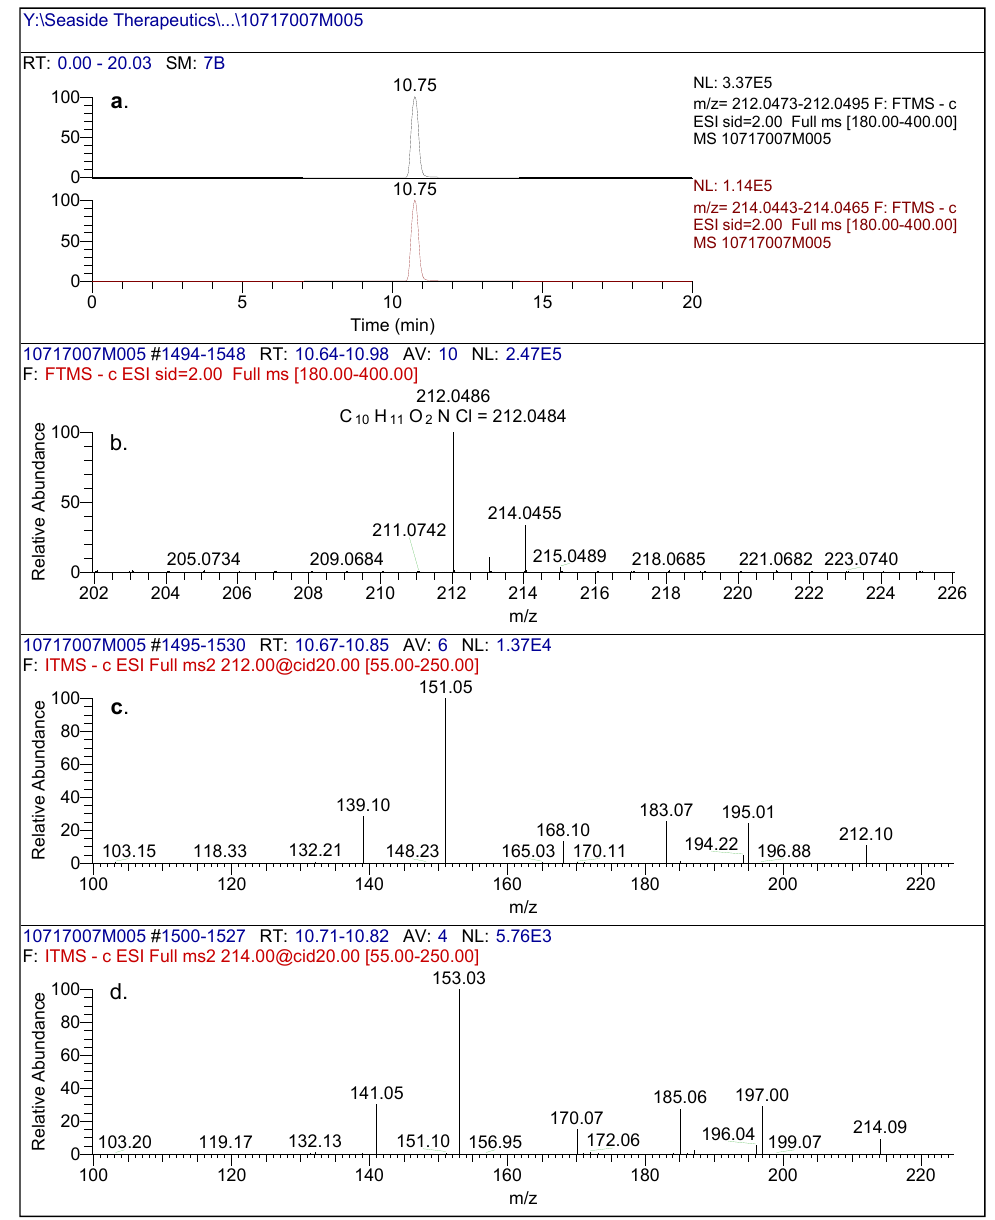
Figure 2. ( a ) High resolution extracted ion chromatogram of baclofen reference standard. ( b ) full scan LC/(-)ESI-FTMS of baclofen reference standard. ( c ) (-)CID-MS/MS spectral data using [M-H]- (212m/z) as the precursor ion and ( d ) (-)CID-MS/MS spectral data using [M-H]- (214m/z) as the precursor